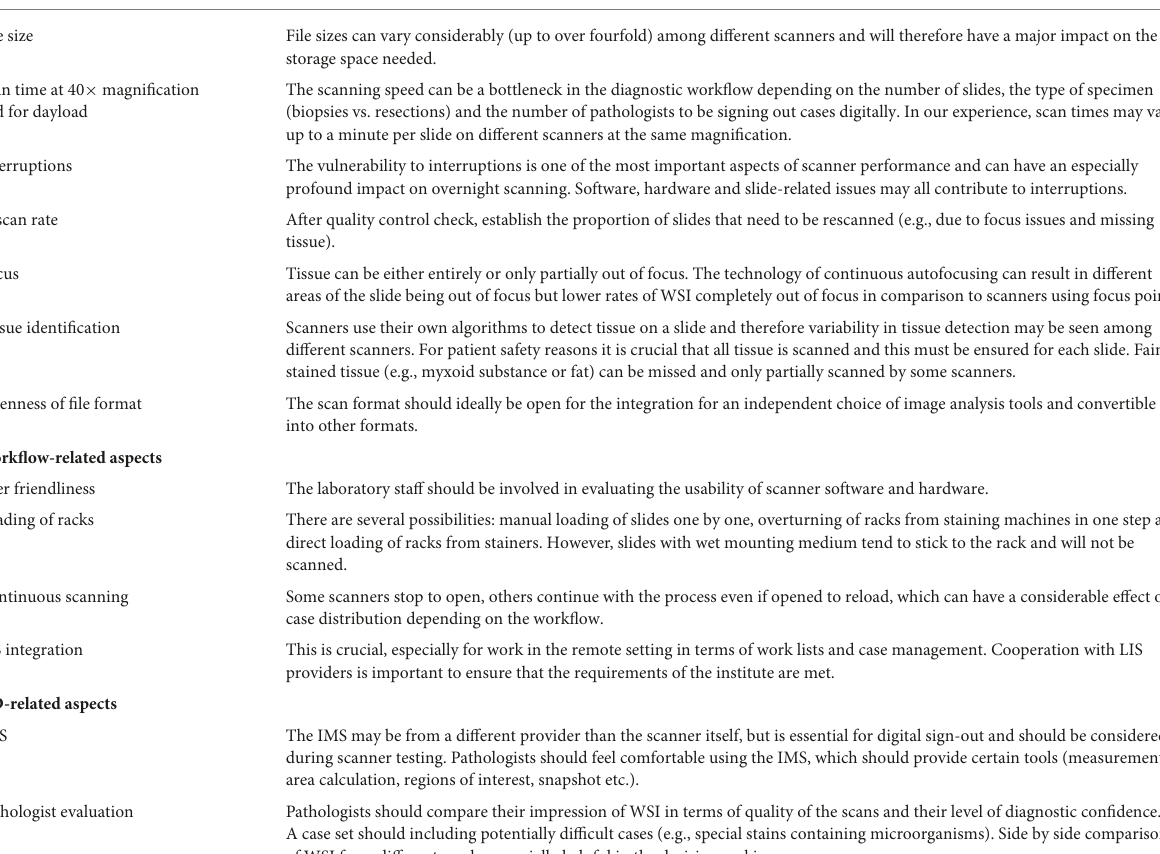
TABLE 1 Example performance test for scanners under consideration for